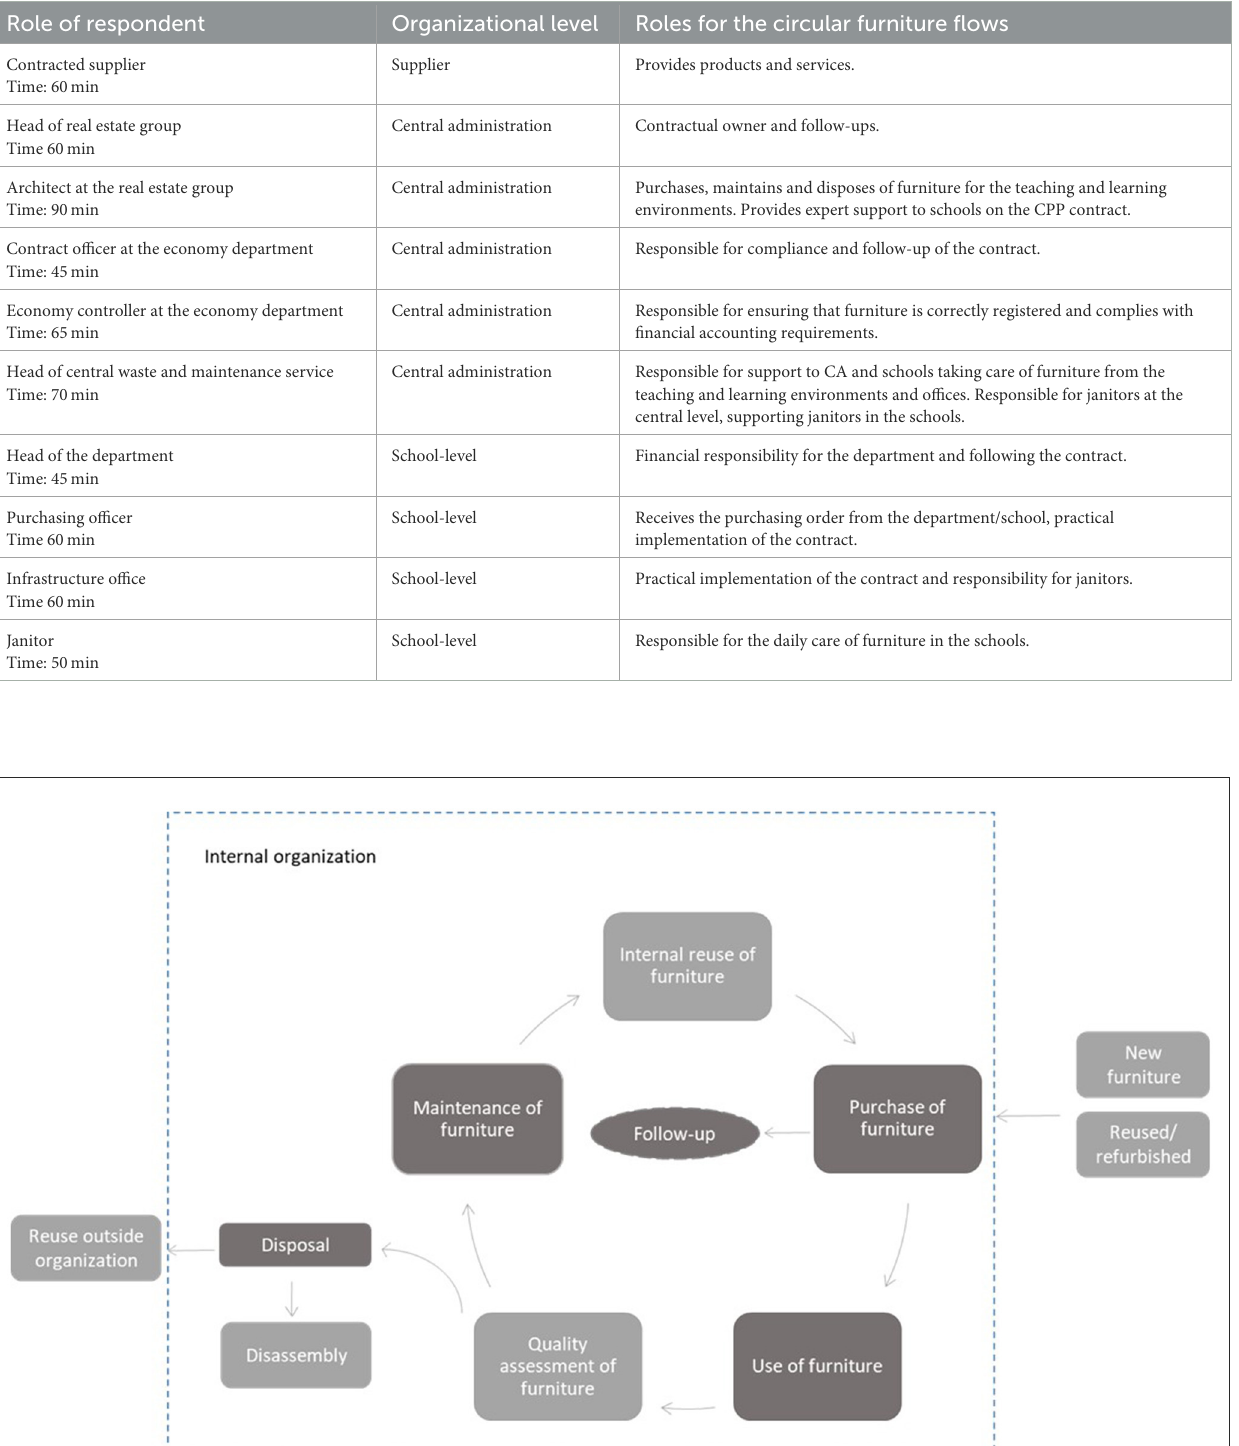
TABLE 2 Interview respondents and their role in the circular furniture flow contract.